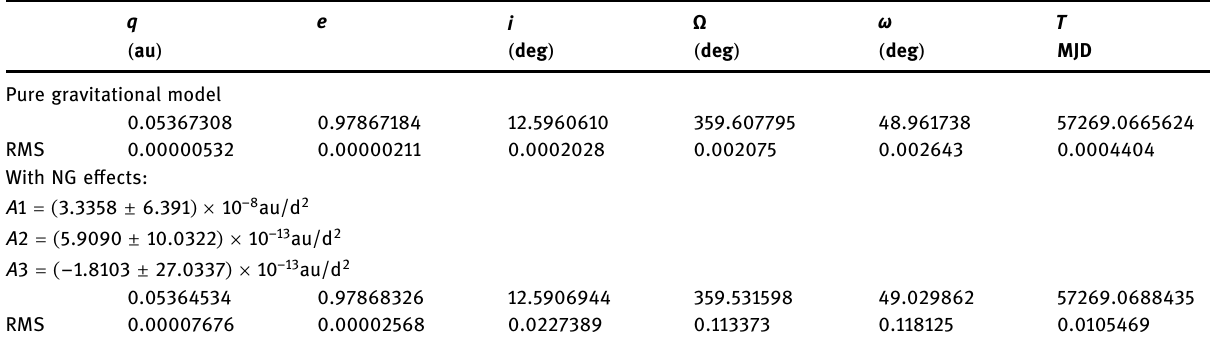
Table 3: Initial nominal cometary orbital elements of comet 322P